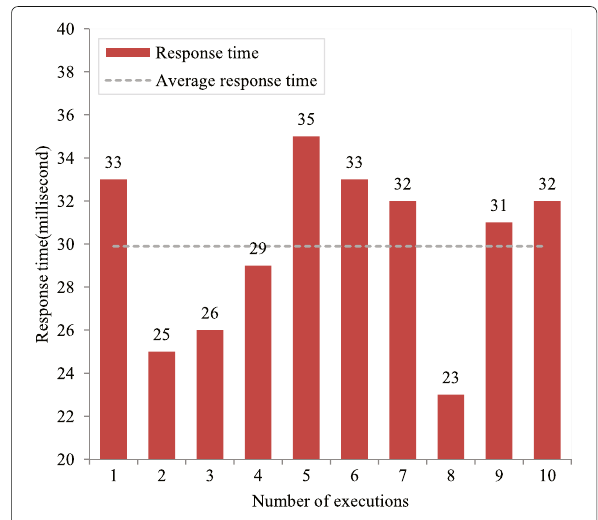
Fig. 11 Service performance of FSP raster